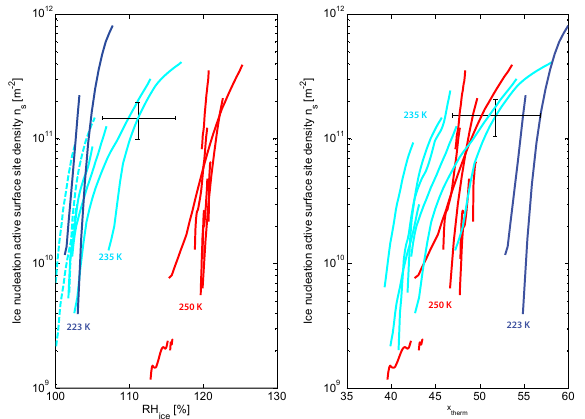
Figure 5. Ice nucleation active surface site densities n s for all experiments starting at 223, 235 or 250K: INAS densities are depicted with respect to relative humidity over ice (left) and with respect to the temperature- and saturation-dependent func- tion x therm (T,S ice ) (right) with x therm (T,S ice ) = − (T − 273 . 2 ) + (S ice − 1 ) × 100; dashed lines represent experiments including larger particles. The error bars represent the measurement uncertainties with (cid:49)n s /n s ≈ 35% and (cid:49)x therm ≈ 5.